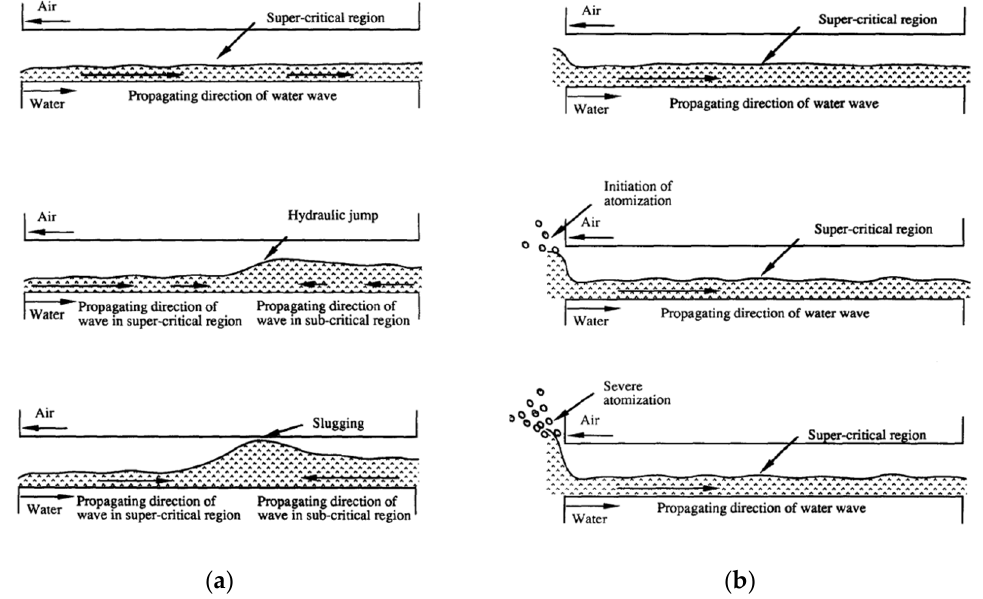
Figure 4. Flow patterns at different inclination angles: ( a ) 𝜃 = 0.69° , ( b ) 𝜃 = 0.92° (Choi and No [38]).